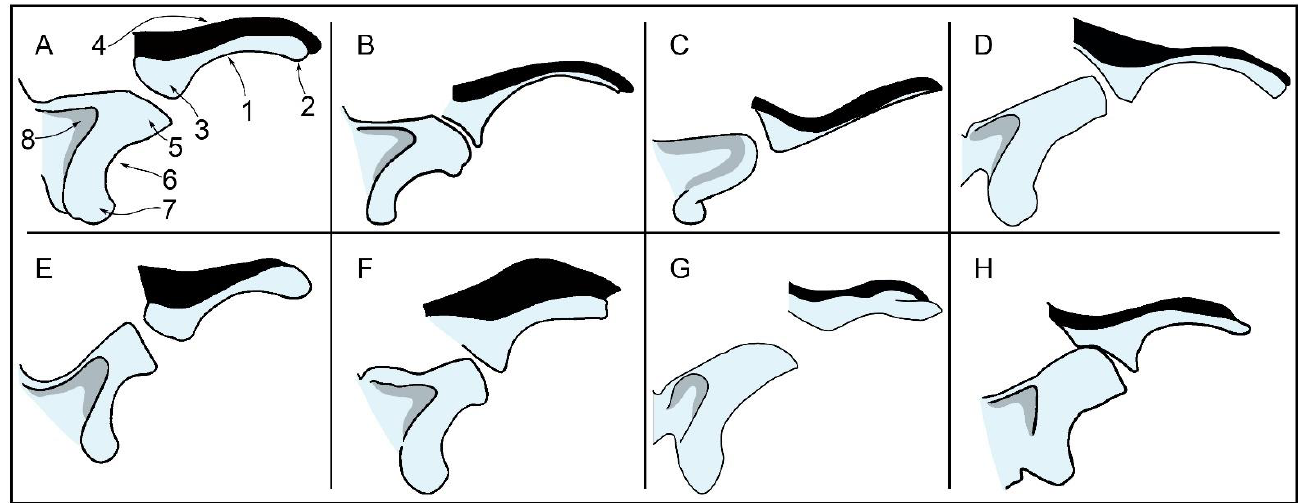
Figure 18. Comparative schemes showing the zygomatic process and the orbit in lateral views to illustrate some of the characters used in the phylogenetic analysis and comparisons sections. 1, thickness of orbital portion of the supraorbital process of the frontal; 2, size of antorbital process; 3, size of postorbital process; 4, relative thickness of maxilla covering of supraorbital process of frontal; 5, shape of anterior end of zygomatic process of frontal; 6, concavity and elongation of glenoid fossa of squamosal; 7, morphology of postglenoid process of squamosal; 8, depth of fossa for sterno- cephalic muscle. Not to scale. ( A ) Eurhinodelphis cocheteuxi . ( B ) Eurhinodelphis longirostris . ( C ) Schizo- cetus sulcatus . ( D ) Mycteriacetus bellunensis . ( E ) Eurhinodelphis morckhoviensis . ( F ) Xiphiacetus cristatus .